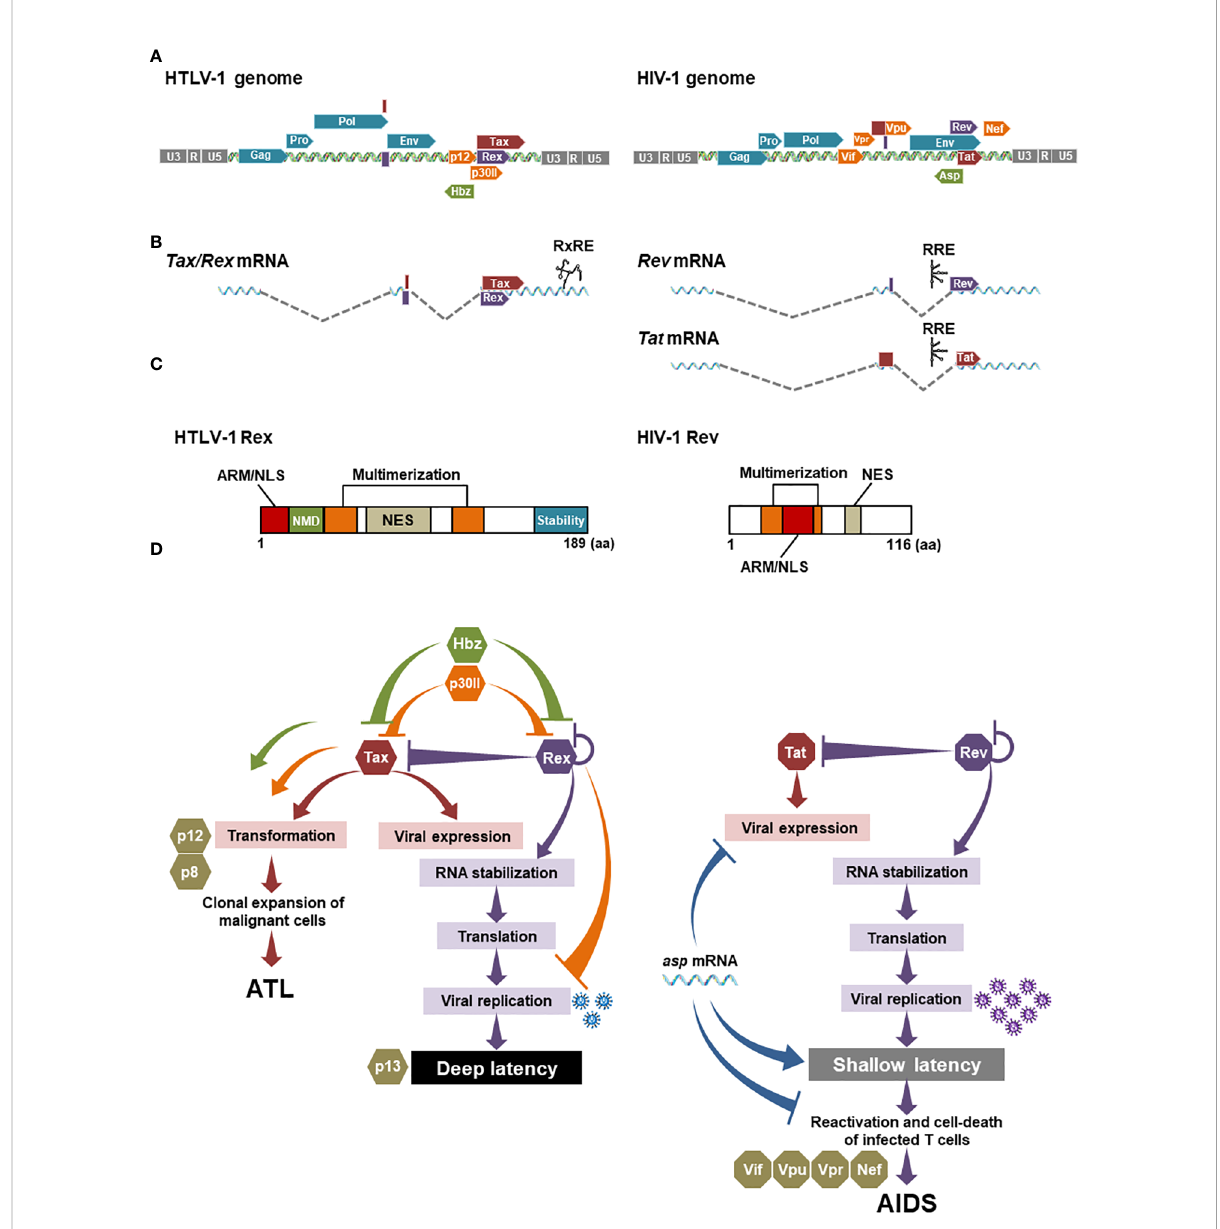
FIGURE 3 Comparison between HTLV-1 Rex and HIV-1 Rev: (A) The genomic structures of HTLV-1 and HIV-1 are similar, with structural proteins encoded on the 5 ′ side and viral accessory proteins including Rex and Rev on the 3 ′ side. (B) Of the several transcriptional variants transcribed